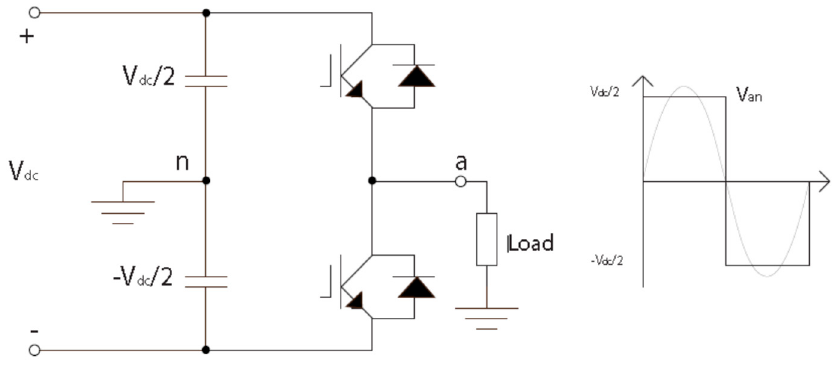
Figure 1. Two-level inverter.